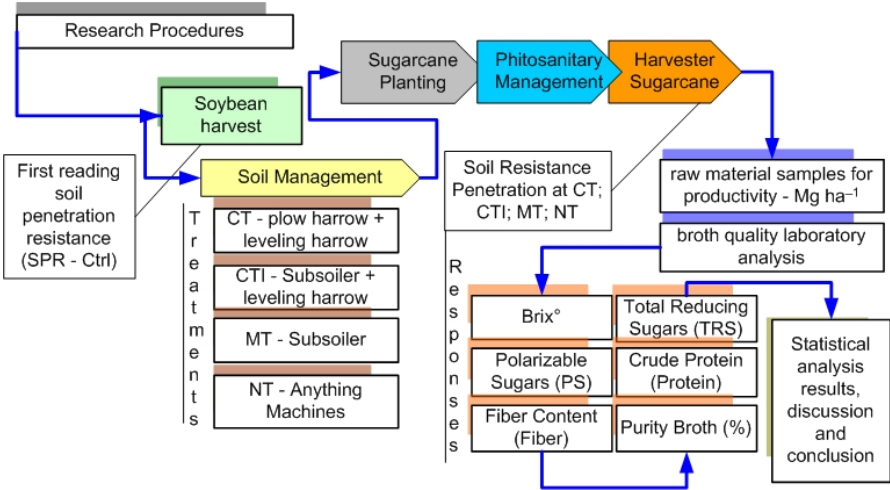
Figure 1. Research procedure, treatments, and response